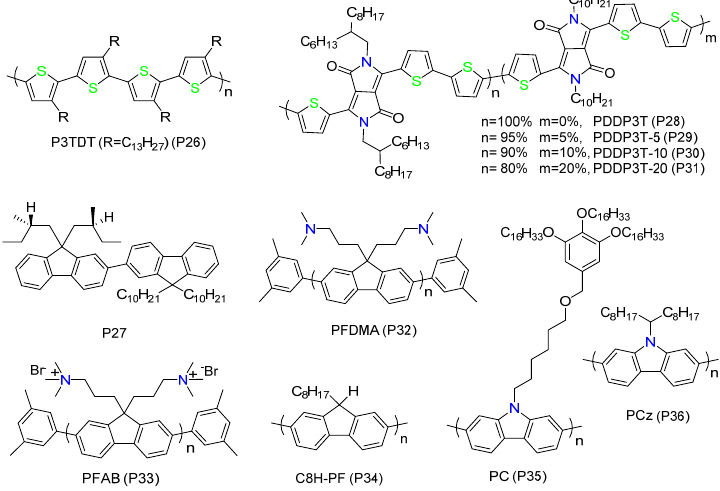
Figure 7. Conjugated polymers used for exploring the side chain effects on sorting.